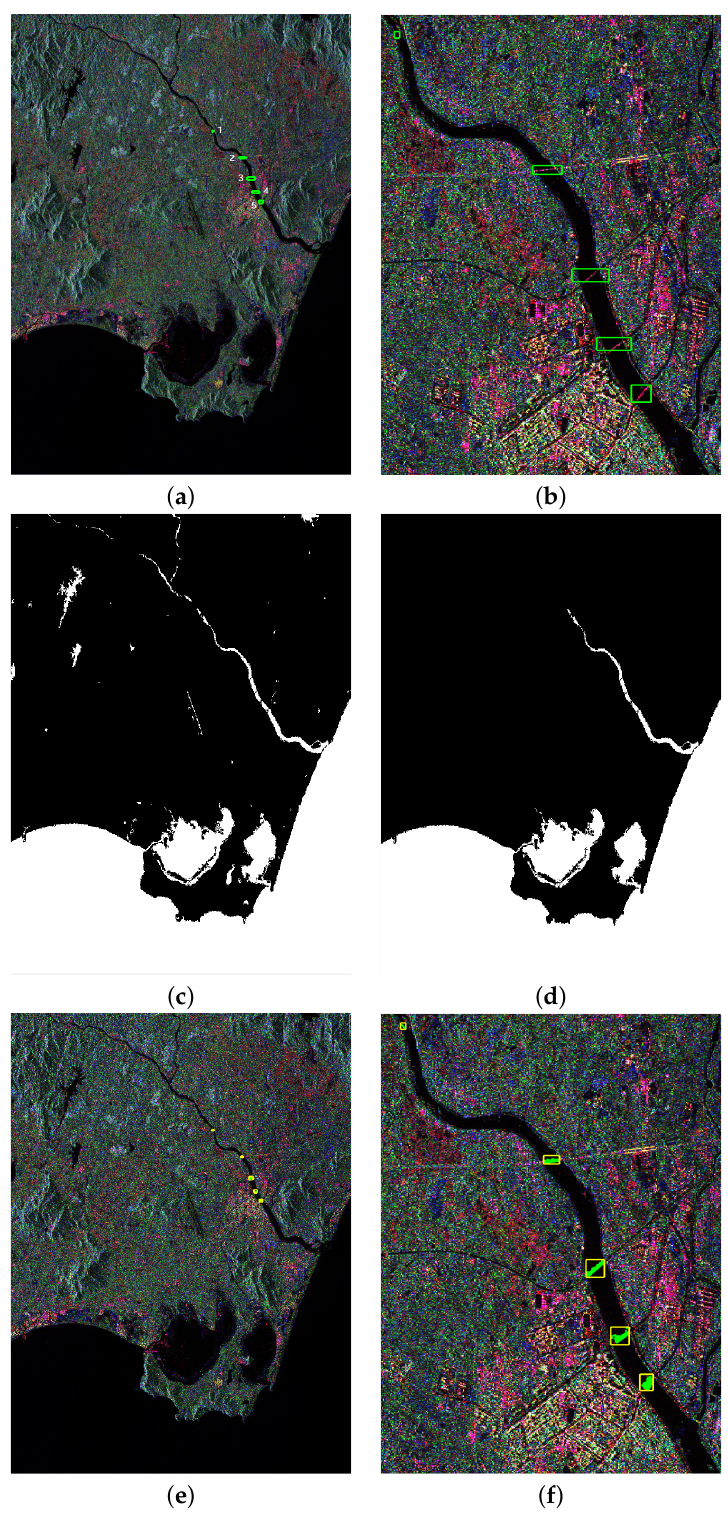
Figure 12. Bridge detection results of data from RADARSAT-2 in Lingshui: ( a ) the Pauli pseudocolor image and the ground truth of the bridges, where the bridges are marked by green boxes; ( b ) an enlarged view of part of the image ( a ) near a narrow tributary; ( c ) the water branch extraction result; ( d ) the water network connection result; ( e ) the bridge detection result; ( f ) the detection result of the enlarged part of ( b